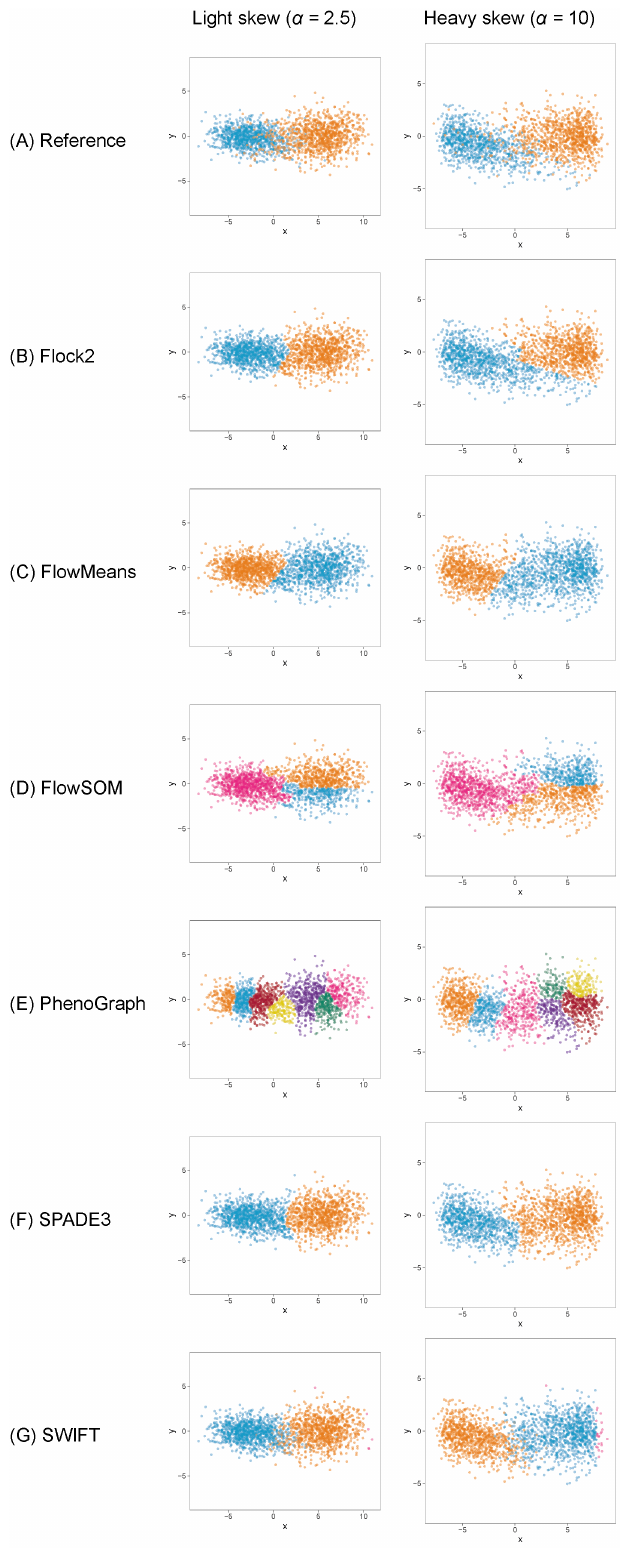
Figure 6. Clustering examples from different software on a two-cluster dataset with skew distribu- tions. Two levels of skew are shown, light skew ( α = 2.5) and heavy skew ( α = 10), with cluster orientations all facing tail to